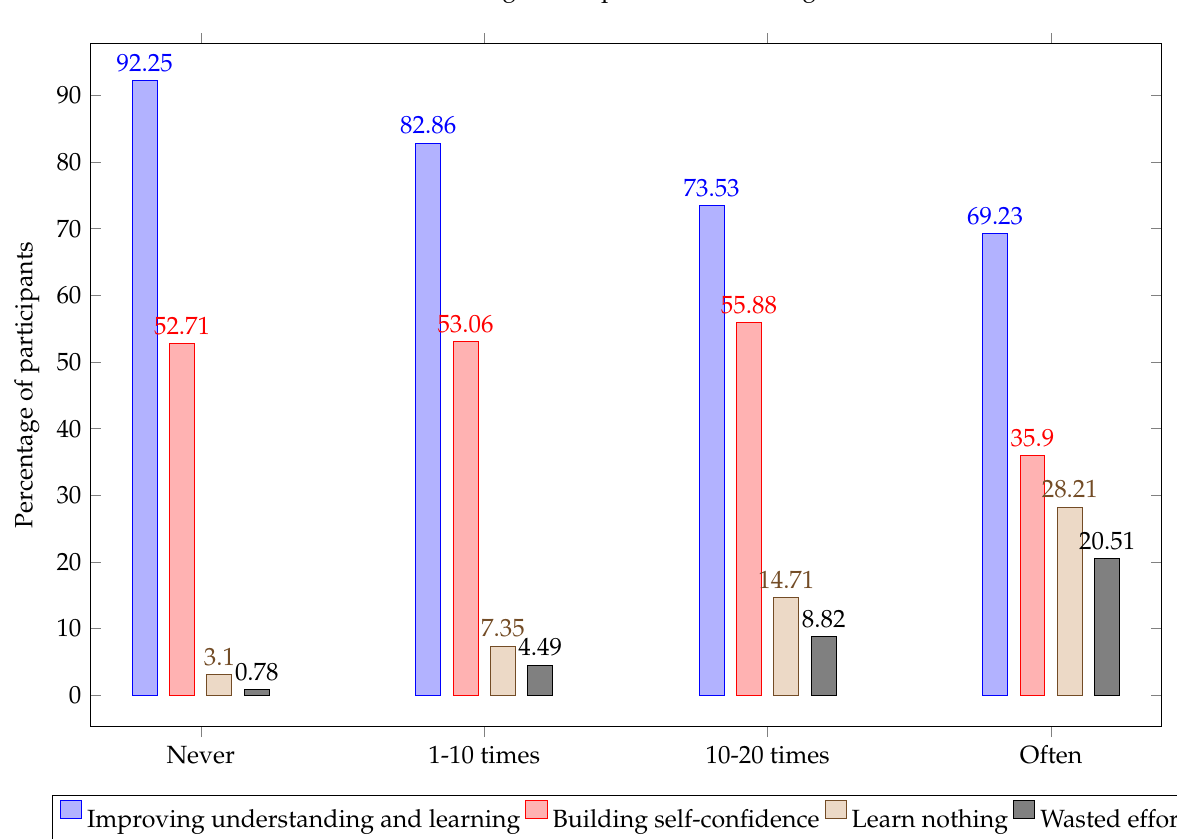
Figure 3. The different accomplishments achieved from the coursework by the different frequencies of student engagement in cheating.